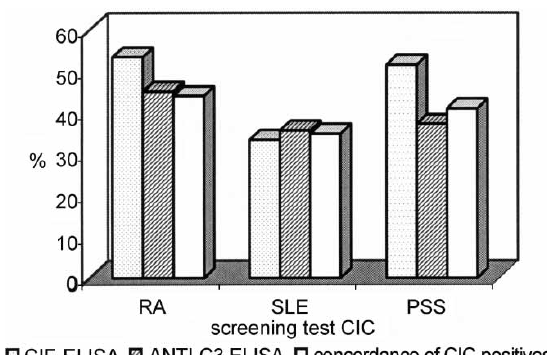
FIGURE 3 The Relative sensitivity and Concordance of total CIC (stCIC) positive sera in patient groups detected by CIF-ELISA and ANTI-C3 ELISA. The relative sensitivity and concordance are calculated as in Fig.